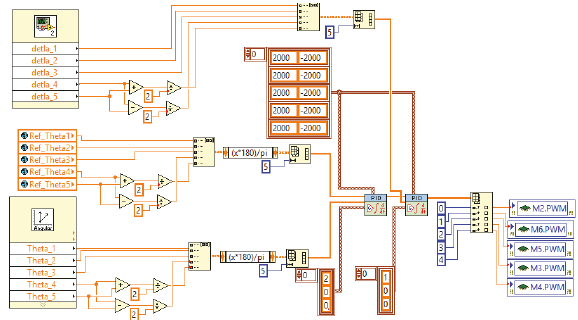
Figure 13: Decoupled control loop diagram.